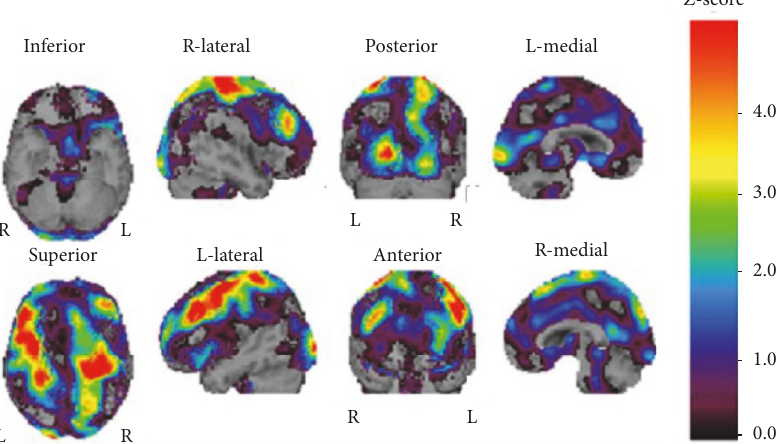
Figure 2: 99 m Tc-ECD SPECT with easy 𝑍 -score Imaging System 10 days after admission showing decreased cerebral blood flow in the bilateral central areas that extends to the frontal and parietal